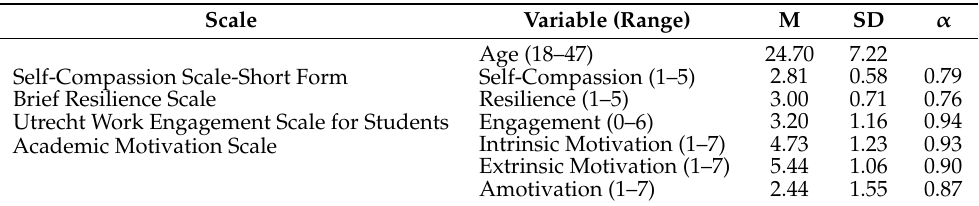
Table 1. Descriptive statistics: self-compassion, resilience, engagement and motivation in Irish social work students ( n = 129).